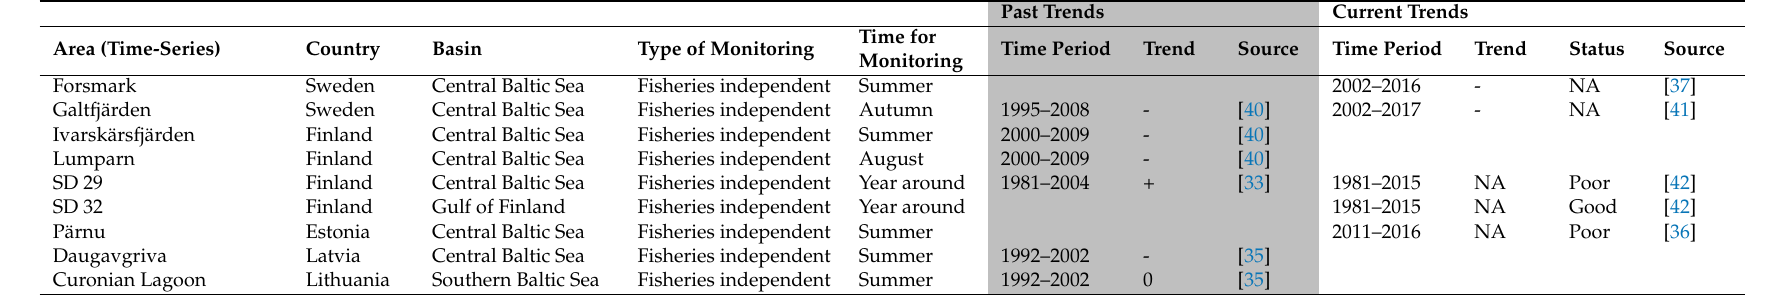
Table 4. Overview of the data and time-series used to assess past (data until the 2000s, grey columns) and current (data until the 2010s white columns) trends and status for pikeperch. The columns “Source” refers to reference